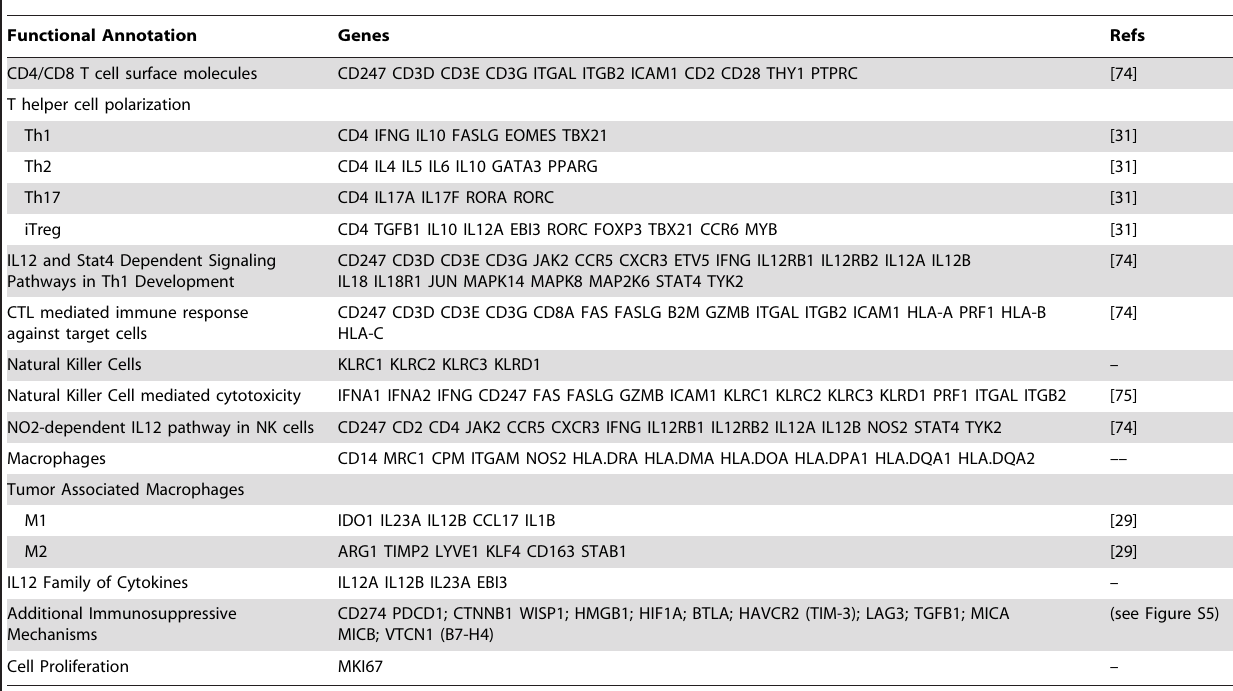
Table 1. Genes associated with type 1 cell-mediated immunity.